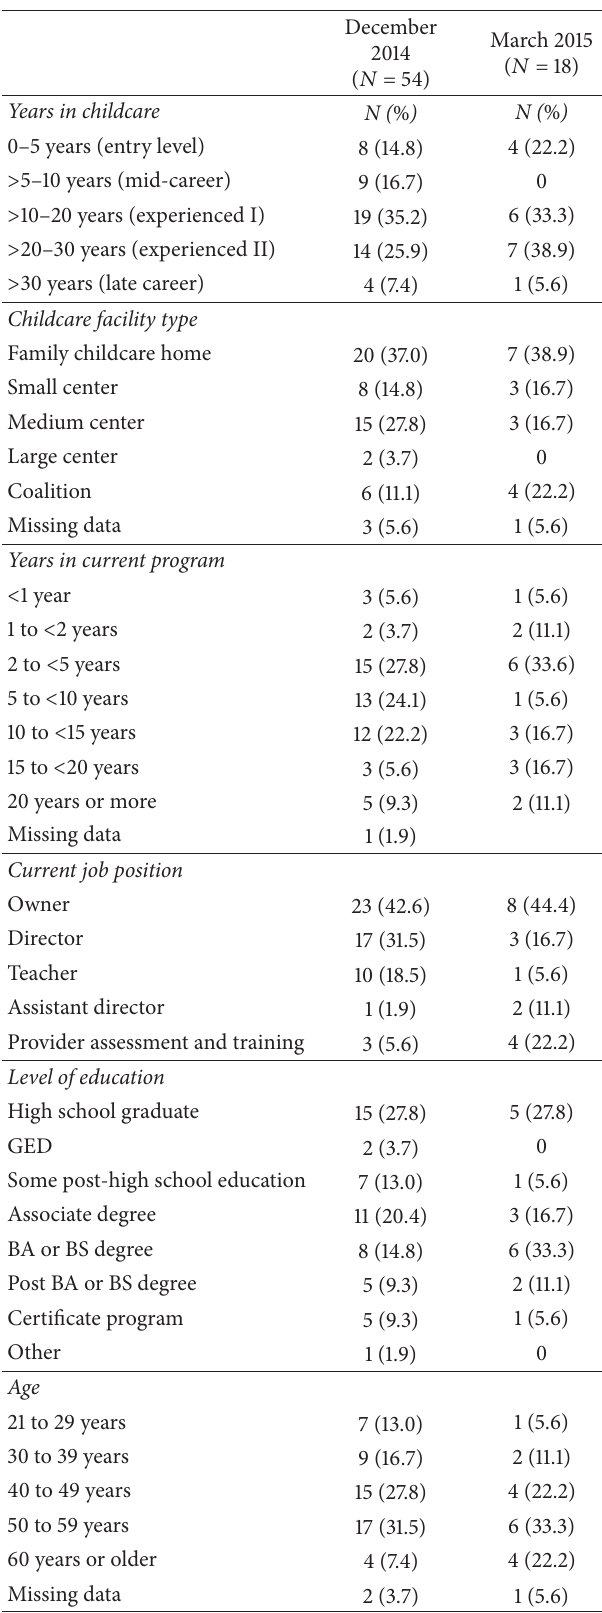
Table 2: Demographic characteristics of key informant and focus group